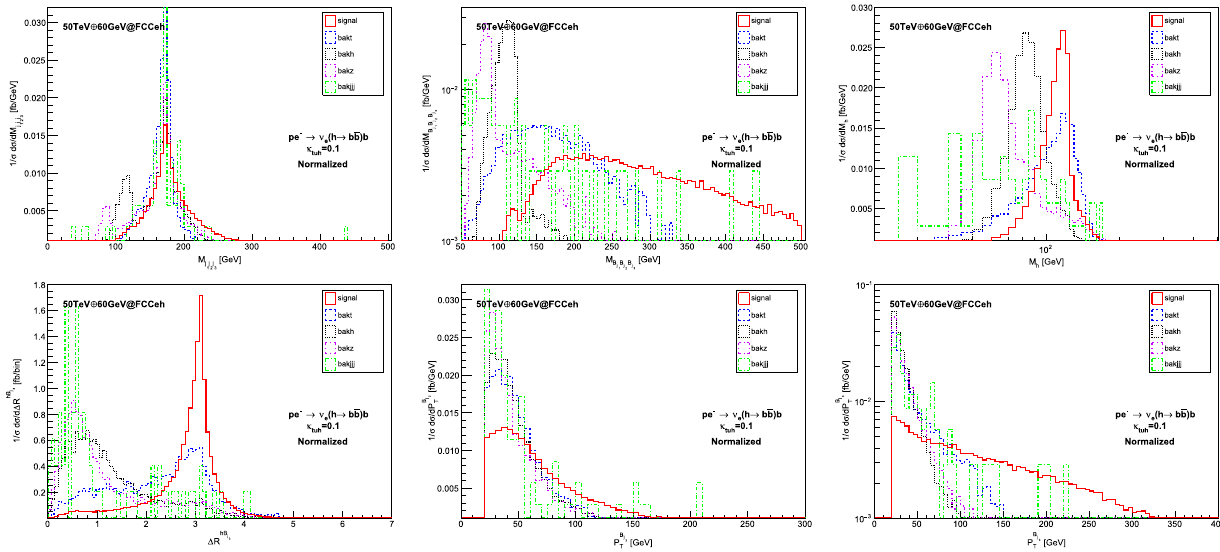
Fig. 4 Various kinematical distributions for signal I and backgrounds at the FCCeh. The electron beam is 60 GeV. Here κ tuh = 0 . 1. Plots are unit normalized